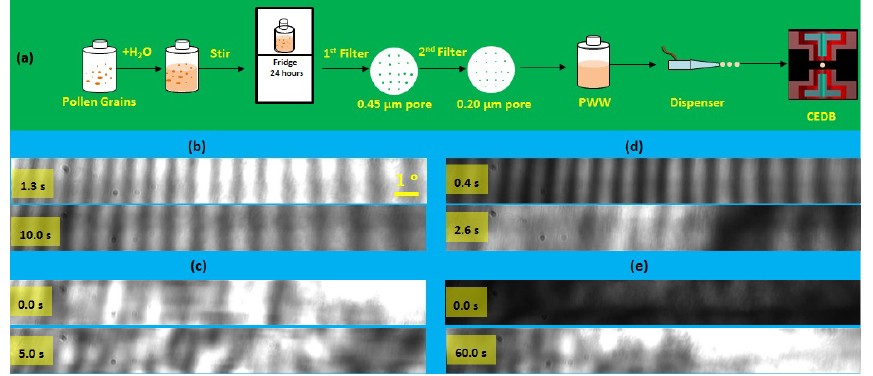
Figure 5. Extraction procedure and example phase-dependent elastic Mie scattering images. (a) Drawings of the extraction procedure of PWW solutions. (b) The phase function of an evaporating PWW particle at − 21.8 ◦ C and recorded at 1.3 (top) and 10.0s (bottom). (c) The irregular phase functions of a PWW particle that froze immediately after injection at − 24.2 ◦ C. (d) The recorded phase functions of a PWW particle that froze after a very short delay at − 24.2 ◦ C. (e) The irregular phase functions of a PWW particle that froze immediately after injection at − 32.2 ◦ C. The angular scale bar (shown in b ) is the same for all the images.